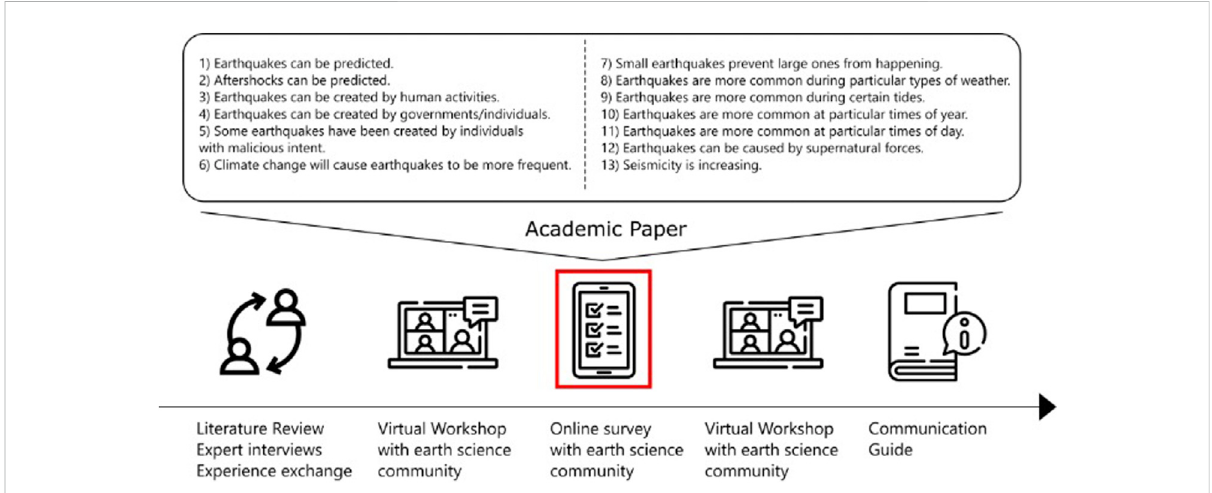
FIGURE 1 Overview of the project activities that the online survey was embedded in, as part of Phase 3 of the project. Includes a literature review, expert interviews(Phase1),avirtualworkshopwithearthsciencecommunitymembers(Phase2),anonlinesurveywiththeearthsciencecommunity(Phase 3), Virtual Workshop with earth science community (Phase 4), and a communication guide (Phase